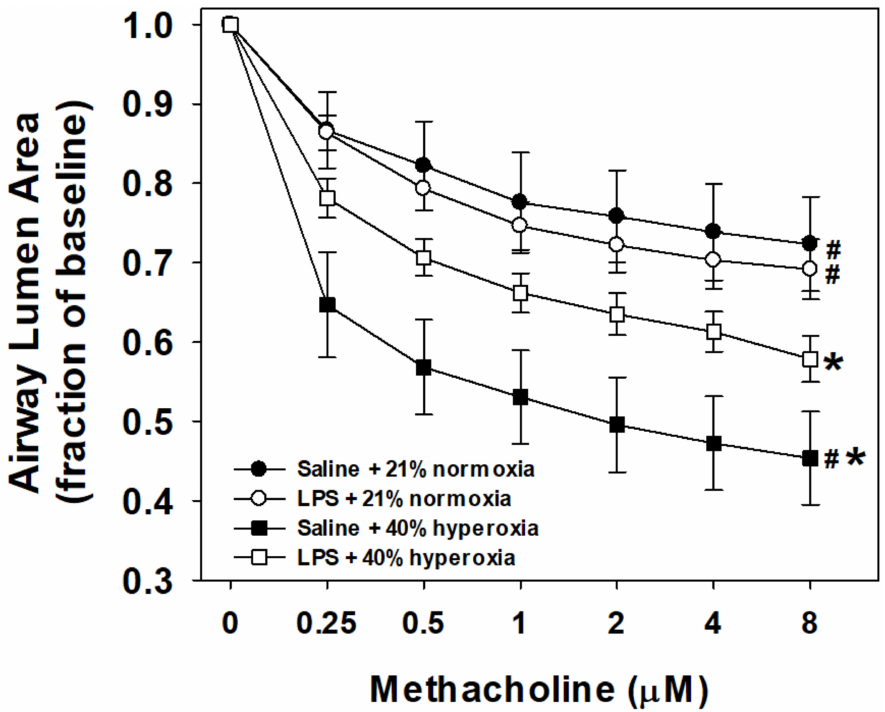
Figure 2. Airway responses to methacholine challenge in the in vitro living lung slice preparation from 21-day-old mice. PCLS airway responses to increasing doses of bath-applied methacholine in mouse pups that received one week of neonatal (P1–7) hyperoxia (squares) or normoxia (circles) and were born from pregnant dams that received an i.p. injection of saline (filled symbols) or LPS (open symbols) at E18 stage of pregnancy. Airways from hyperoxia-exposed mice pretreated with maternal saline were the most reactive (steeper slope, maximum airway contraction). Maternal LPS treatment and postnatal hyperoxia (open squares) significantly increased airway reactivity compared to control (saline + normoxia; filled circles), but attenuated the reactivity of hyperoxia alone (filled squares). Maternal LPS alone (open circles) did not differ in airway reactivity compared to control mice. Values are the means ± 1SEM. Significant differences in the dose response to methacholine: *vs. saline+normoxia ( p < 0.05); #vs. LPS+hyperoxia ( p <